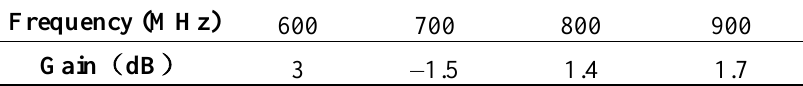
Table 2. Measured gain of the microstrip antenna.